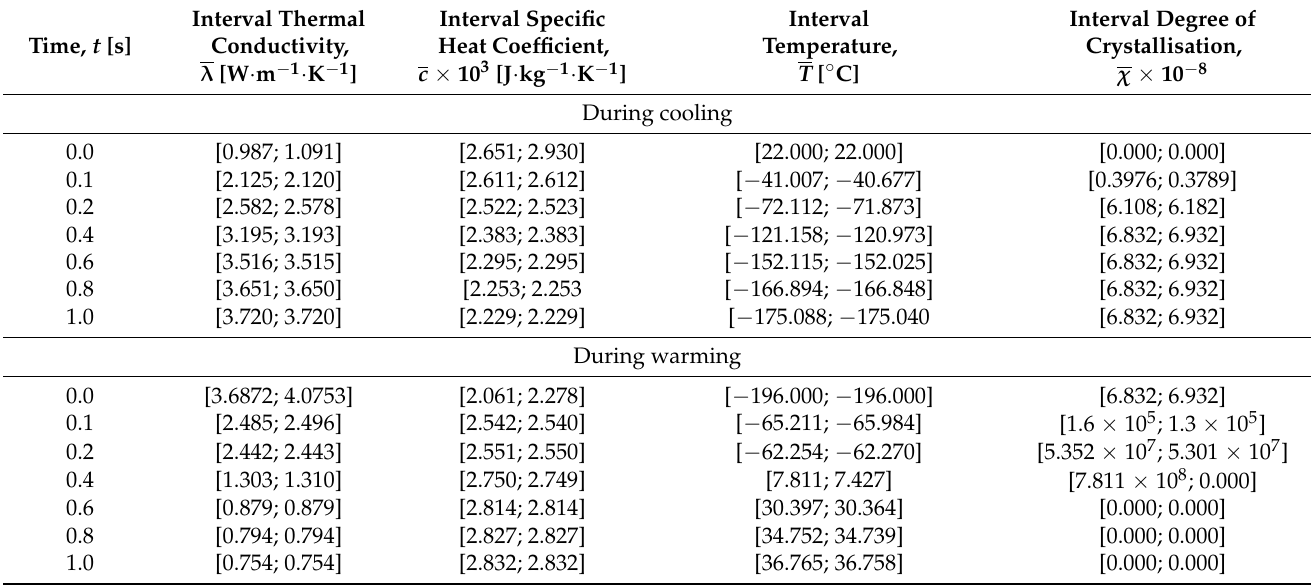
Table 2. Selected interval results.